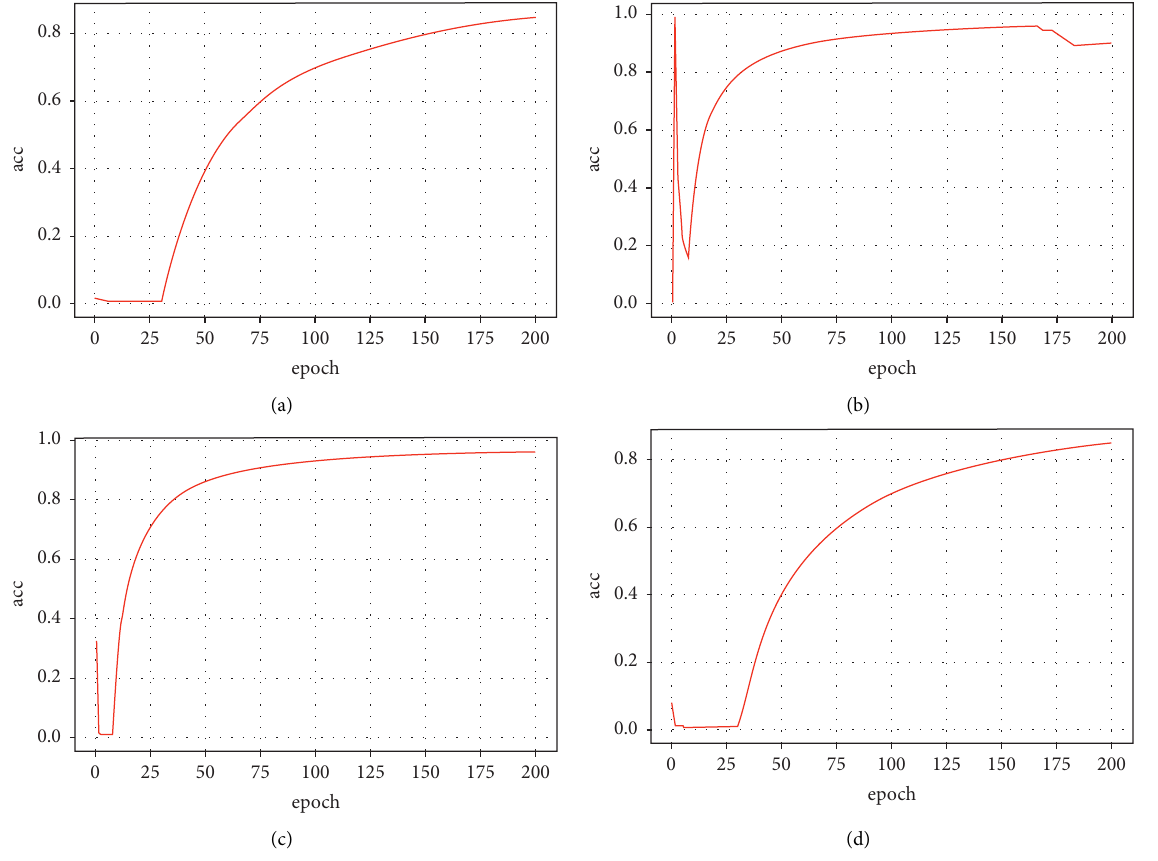
Figure 4: The random training process of four participants. Table 3: ALL-LSTM model classification results.